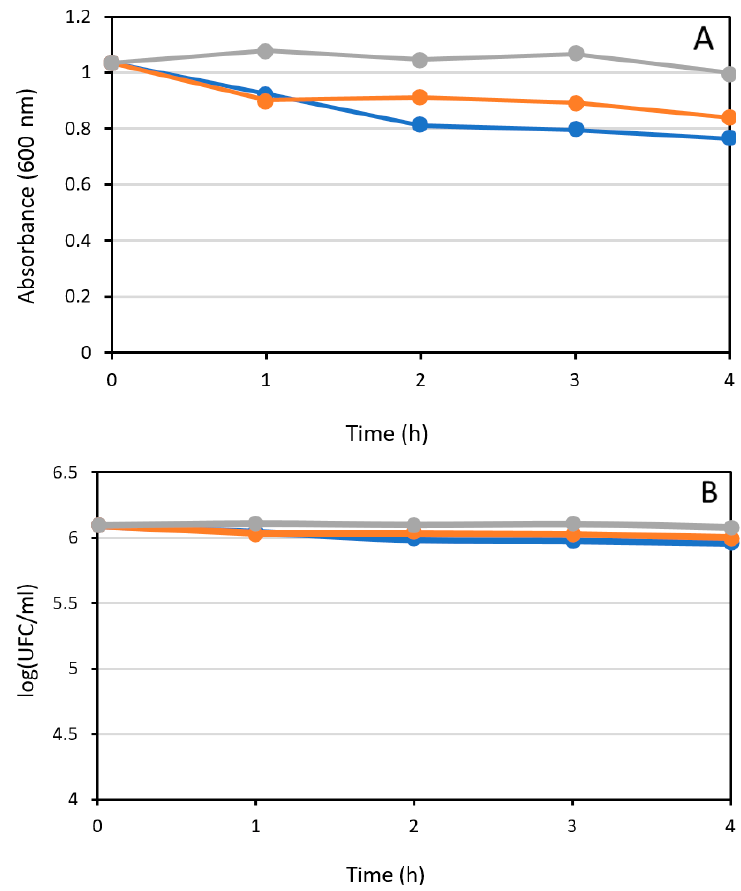
Figure 9. Adsorption kinetics of Salmonella on montmorillonite and mont-PCH measured in absorbance ( A ) and concentration ( B ). The three treatments are: control (grey line), montmorillonite (blue line) and montmorillonite-PCH (orange line).